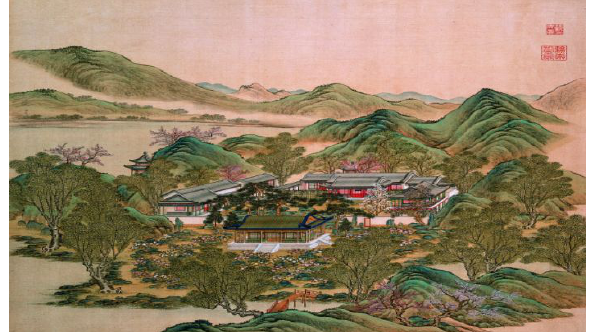
Figure 1. Forty scenes of the Yuanmingyuan of the Scenic Area